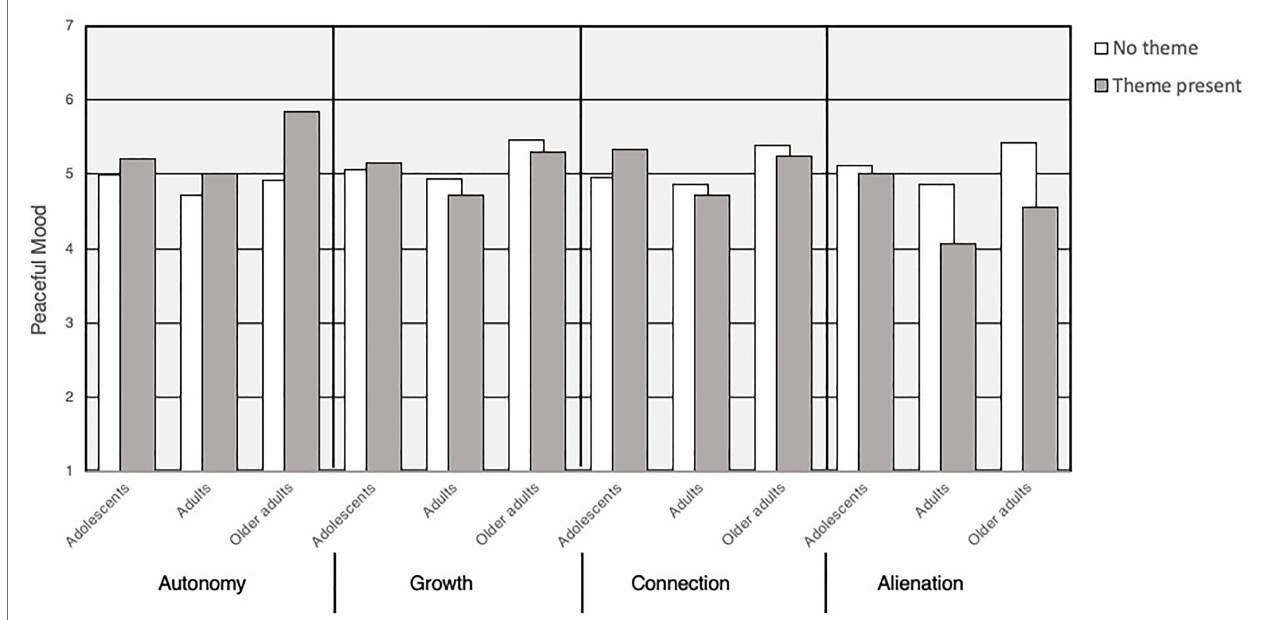
FIGURE 2 | Interaction effects: means of peaceful mood (y axis) as a function of each theme [absent (white) or present (gray)], and separately adolescents, adults, and older adults (x axis). Means were derived from PROCESS moderation analyses for illustration purposes and may slightly differ from simultaneous regression